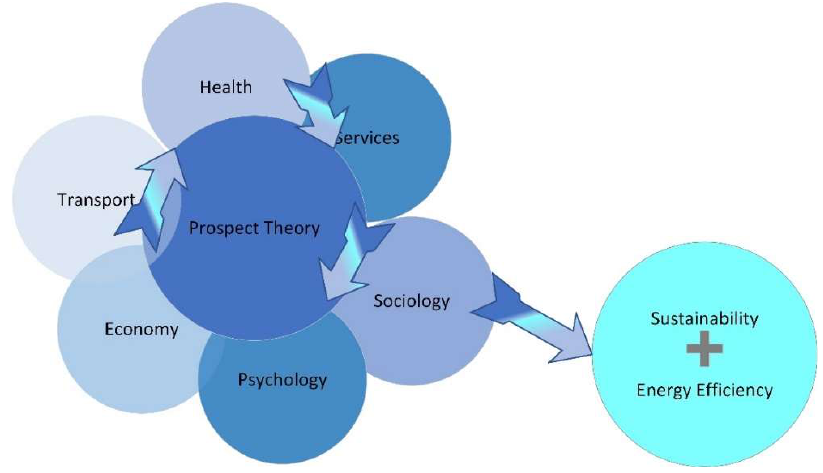
Figure 1. Studies on relationships with Prospect Theory.